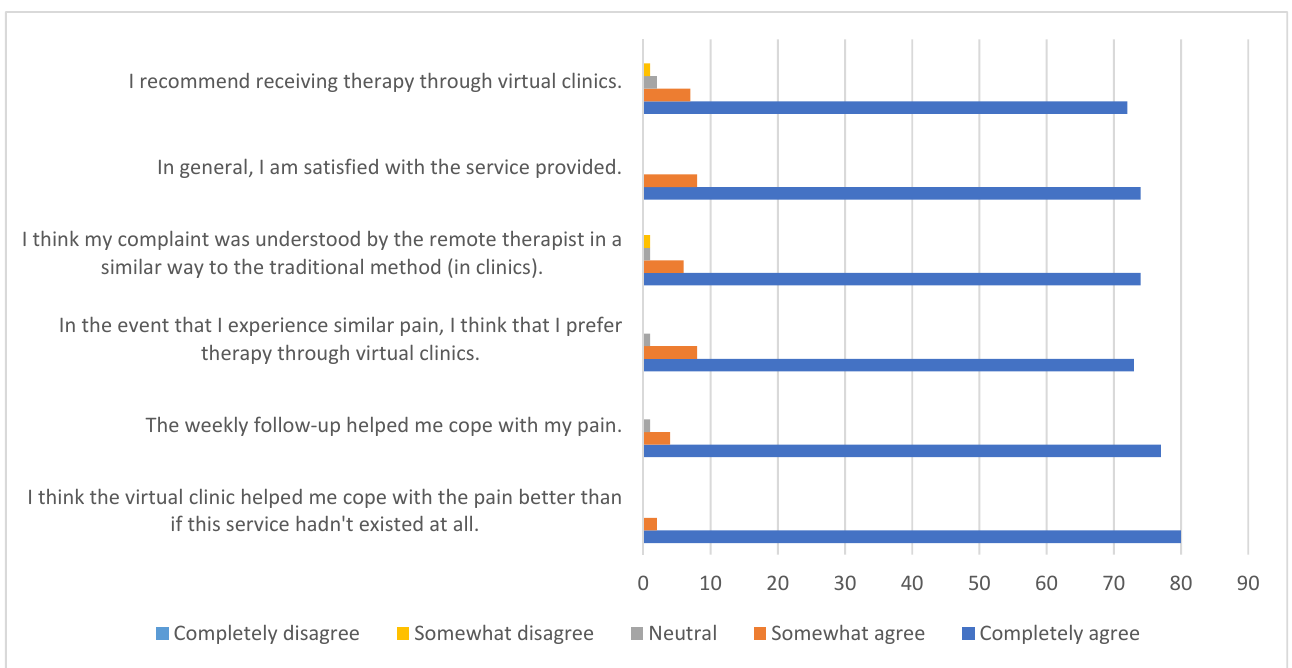
Figure 3. Boxplot of mean and SD for Patient-Specific Functional Scale (PSFS) scores at baseline and follow-up.